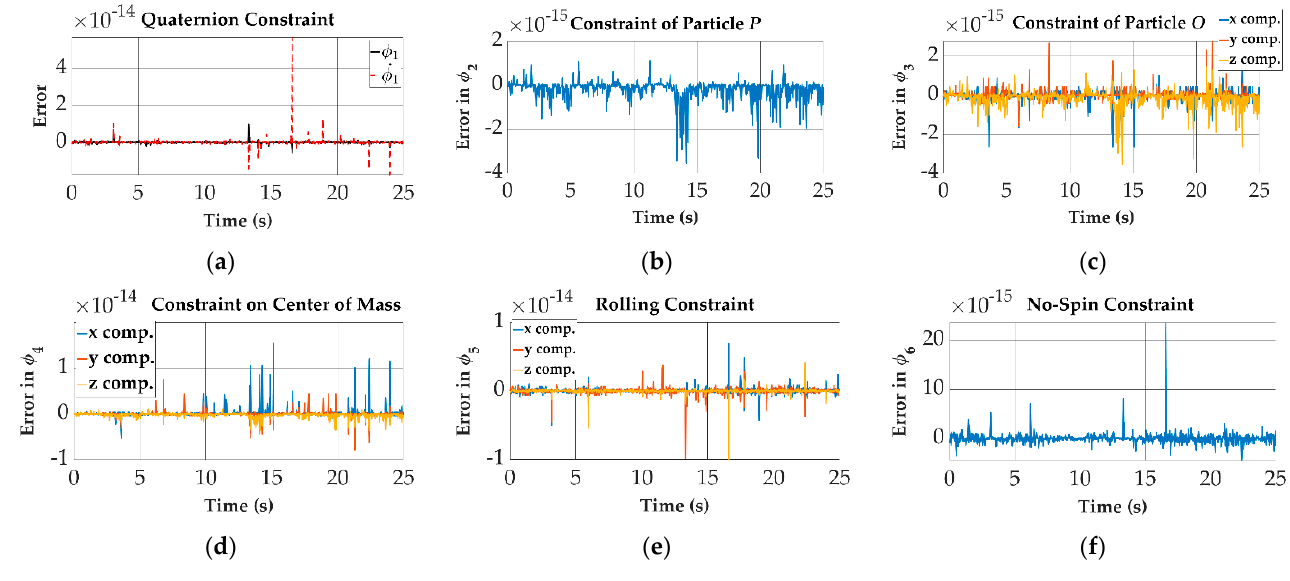
Figure 13. Example 3. Case C. Time history of the numerical errors in the satisfaction of the constraints ( a ) ϕ 1 , ( b ) ϕ 2 , ( c ) ϕ 3 , ( d ) ϕ 4 , ( e ) ϕ 5 , ( f ) normalized ϕ E 1